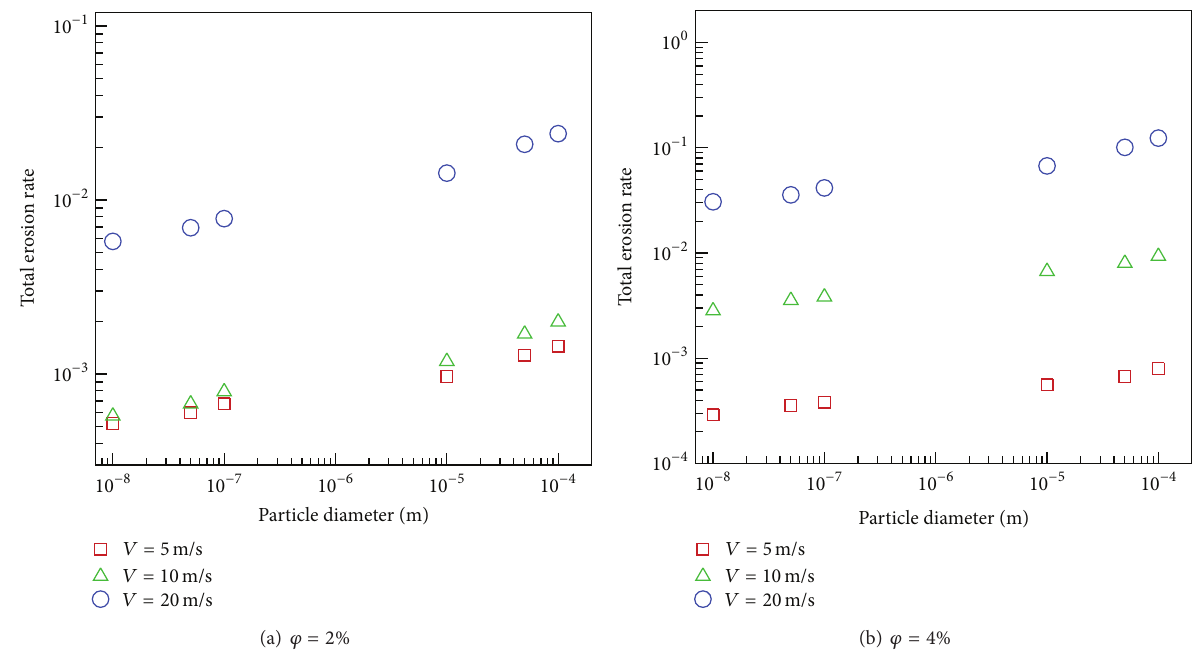
Figure 7: The variation of particle size with total erosion